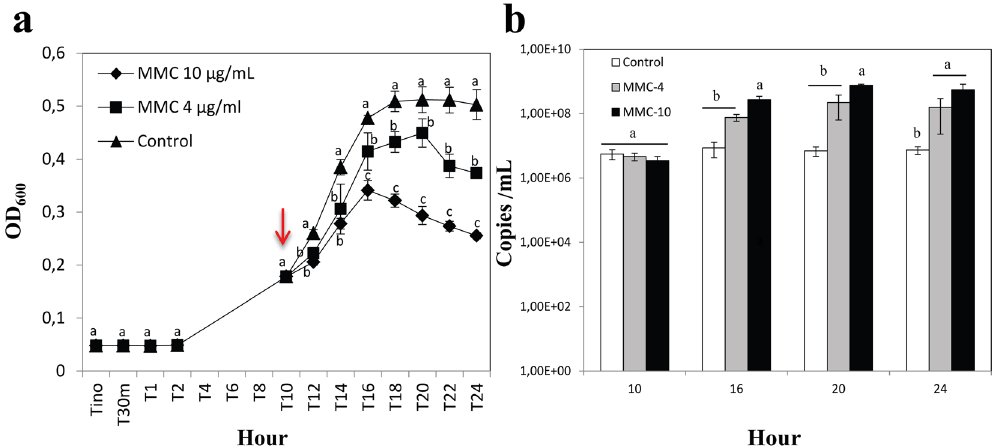
Figure 1. (a) Prophage induction and (b) quantitative PCR of the progeny. The MMC was added with a different concentration, MMC-4 (4 µ g/mL) ( ■ ), MMC-10 (10 µ g/mL) ( ♦ ) and without MMC/control ( ▲ ) to exponential-growing cell (10 hour; indicated with red arrow) of incubation in LB medium at 28 °C. Sample from 10 hour, 16 hour, 20 hour and 24 hour were used for quantitative PCR, error bars indicated s.d. values ( n = 3). Significant of the treatments are marked with letter ( a , b ) for P < 0.05.